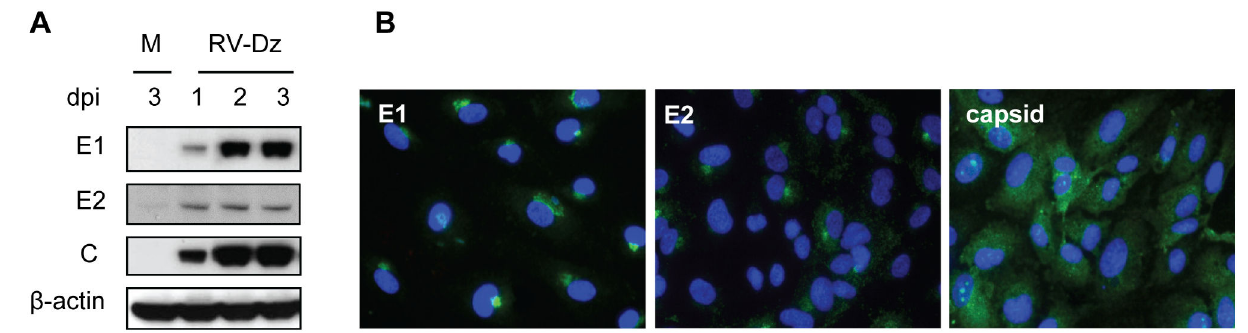
Figure 2. Expression of viral structural proteins in infected HUVEC. ( A ) Kinetics of viral protein synthesis. HUVEC were mock infected (M) or infected with RV-Dz at an MOI=5. Proteins were separated by 4-12% NuPage gel, either nonreducing (E1, C, β- actin) or reducing (E2), and then the blots were probed with rubella E1, E2 and C-specific MAb and β-actin MAb. ( B ) Spatial distribution of E1, E2 and C proteins in infected cells. HUVECs were infected with RV-Dz at an MOI=5 on chamber slides and processed for indirect immunofluorescence at 2 dpi using E1, E2 and capsid-specific MAb. Nuclei were counterstained with DAPI. doi: